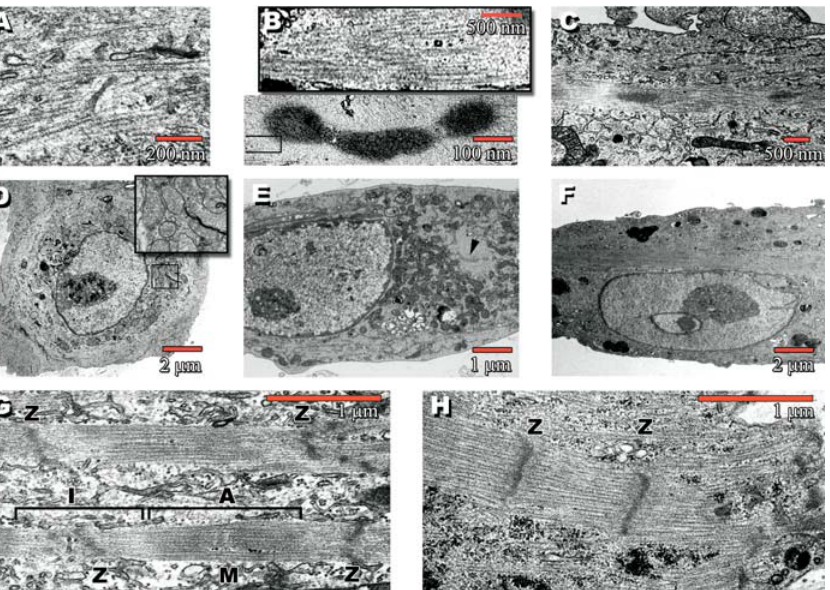
Figure 4. Transmission EMs Show the Post-Replating Progression of CPS Cells (A) Round, day 3 cells contain disordered myosin filaments. Some of these cells beat while still floating (see Video S1) and typically have APs as shown in Figure 6A. (B) Upper box is a blowup taken from lower panel, showing myosin filaments of characteristic 1.6- l m length radiating outward from dense body. (C) Day 14 cell with a single, central nucleus shows a stretching out of the dense bodies into an organizing sarcomere. (D) Day 3 round cells containing copious mitochondria (inset). (E) Elongated day 7 cell containing a dense body (arrowhead). (F) Uninucleate day 14 cell, same cell as in (C). (G) By day 56, a well-defined sarcomere is present, with identifiable A- and I-bands and M- and Z-lines. (H) Sarcomere from a fetal cardiomyocyte is shown for comparison. DOI: 10.1371/journal.pbio.0030087.g004